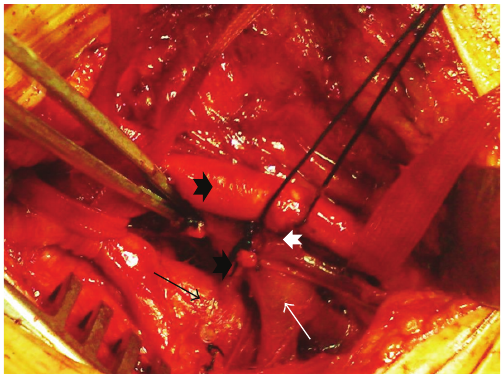
Figure 1: CT angiography examination of the patient. Contrast passage between the femoral artery and vein (arrow heads) is demonstrated. (Black arrow: common femoral artery, white arrow: common femoral vein).